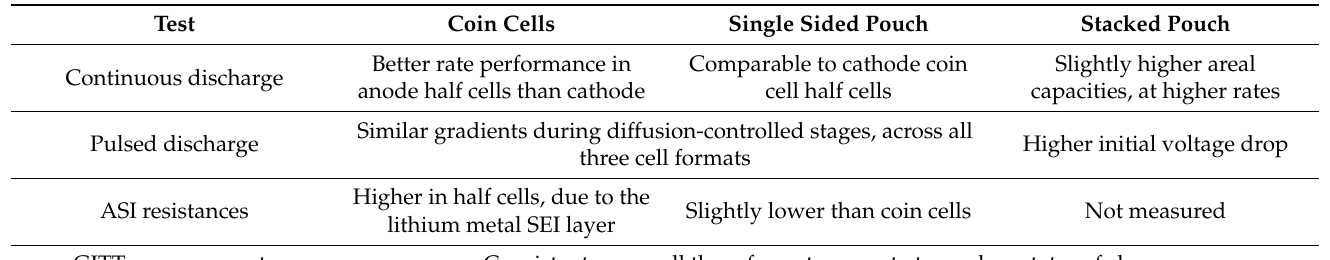
Table 4. Summary of comparative performance of different cell